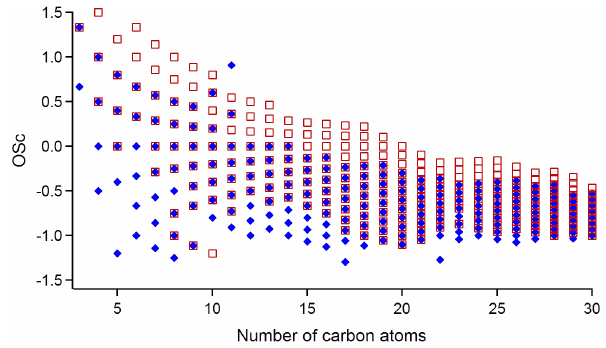
Figure 5. Carbon oxidation state of the molecules in SOA from ozonolysis (blue diamonds) and OH-initiated reaction (red squares) of α -pinene.